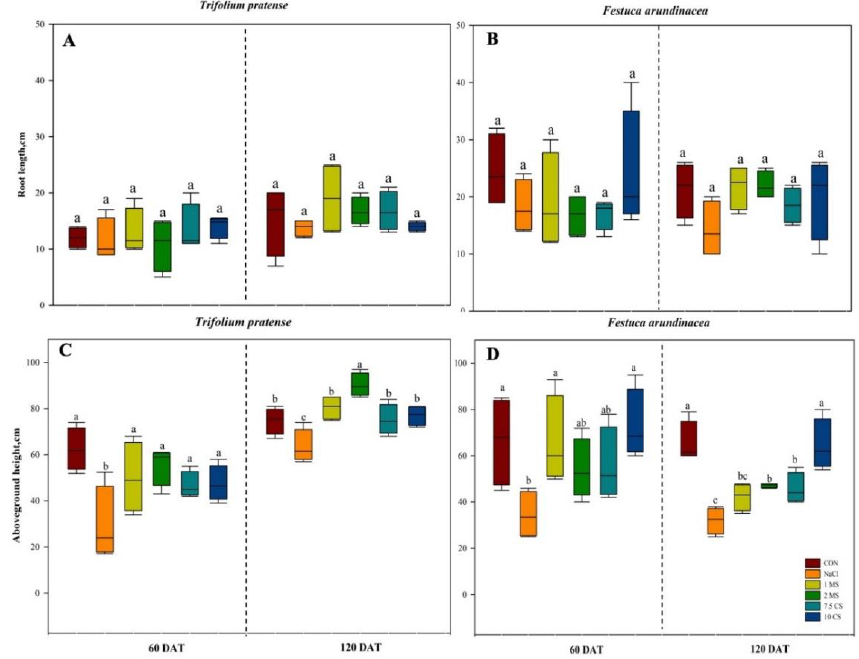
Figure 1. Evaluation of T. pratense ( A , C ) and F. arundinacea ( B , D ) by analyzing height and root length under six different treatments. Plants were treated with 100 mM NaCl solution; 1 mM MgSO 4 + 100 mM NaCl (1 MS); 2 mM MgSO 4 + 100 mM NaCl (2 MS); 7.5 mM CaSO 4 + 100 mM NaCl (7.5 CS); and 10 mM CaSO 4 + 100 mM NaCl (10 CS), within calculated 60 DAT and 120 DAT. Vertical bars represent standard errors ( N = 4). Different lowercase letters indicate significant differences among the treatments at α = 0.05.